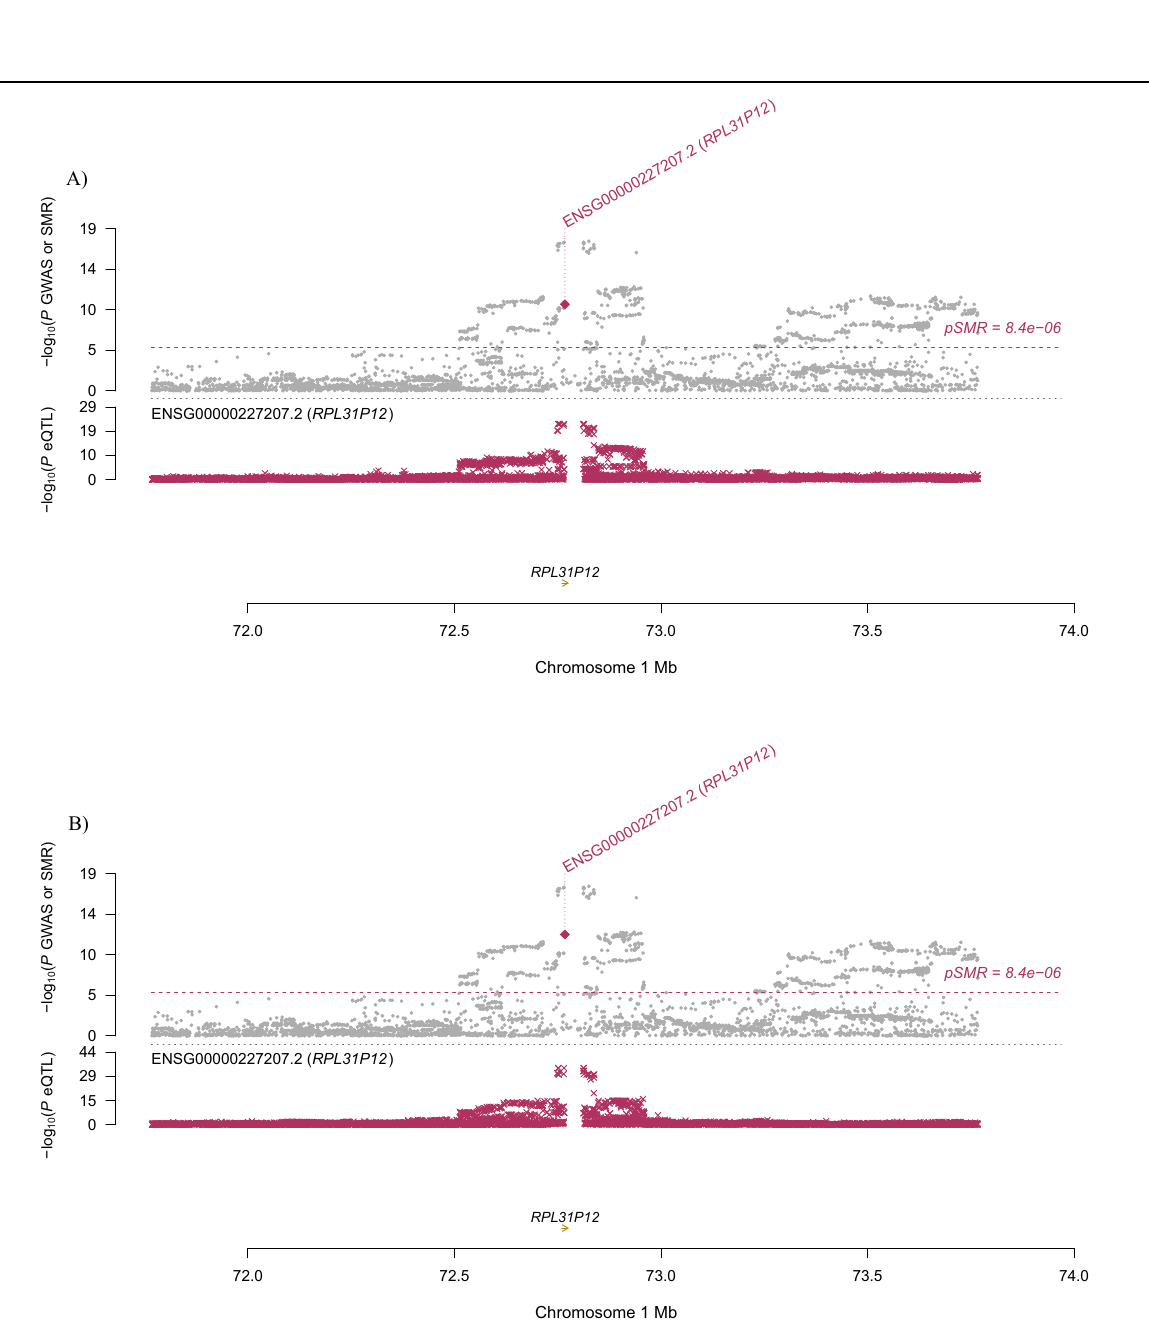
Fig. 2 Prioritizing genes around RPL31P12 in pleiotropic association with MDD. A Cerebellar hemisphere. B Cerebellum. Top plot, gray dots represent the − log 10 ( P values) for SNPs from the GWAS of MDD, and rhombuses represent the − log 10 ( P values) for probes from the SMR test with solid rhombuses indicating that the probes pass HEIDI test and hollow rhombuses indicating that the probes do not pass the HEIDI test. Middle plot, eQTL results for the probe ENSG00000227207.2 tagging RPL31P12 . Bottom plot, location of genes tagged by the probe. Highlighted in maroon indicates probes that pass the SMR threshold. GWAS genome-wide association studies, MDD major depressive disorder, SMR summary data-based Mendelian randomization, HEIDI heterogeneity in dependent instruments, eQTL expression quantitative trait